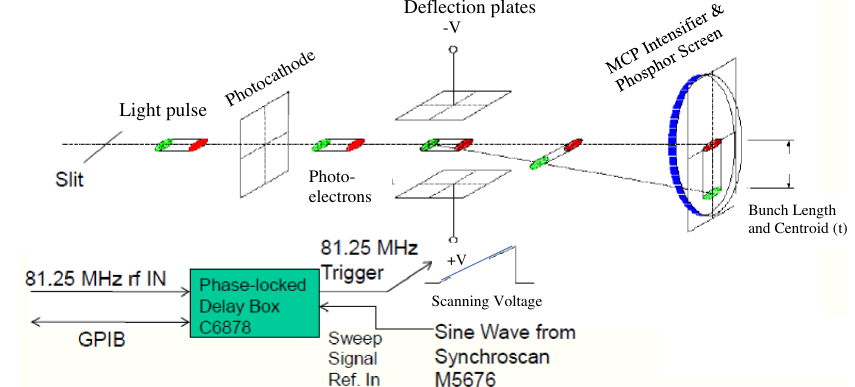
FIG. 2. Schematic of the streak-camera principles where the vertical axis is converted to a time axis with the ramped voltage on a set of deflection plates and timing is synchronized to an 81.25-MHz rf signal for picosecond phase stability. In this case, the head of the pulse (red) is undeflected, and the tail of the pulse (green) is deflected the most vertically downward. It also could be shifted by SRW left or right, and this searched-for effect would also be displayed in the image [12].